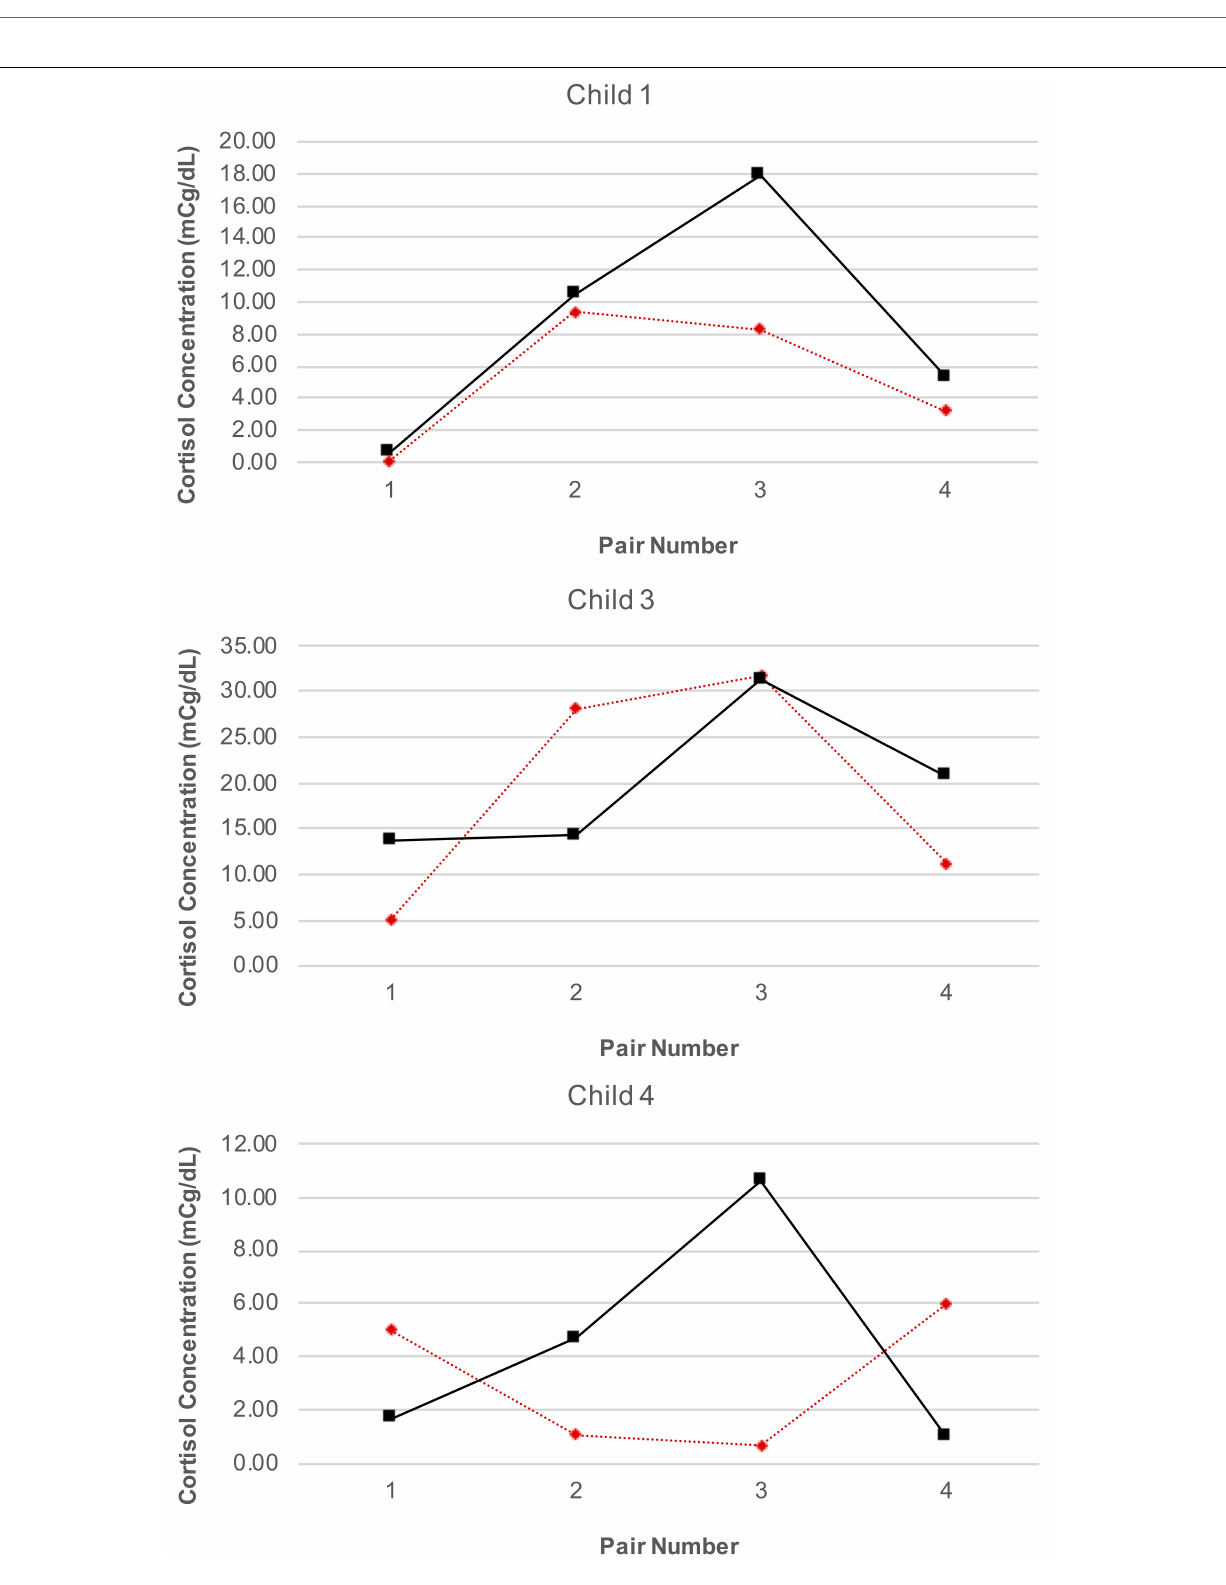
FIGURE 6 | Child blood cortisol